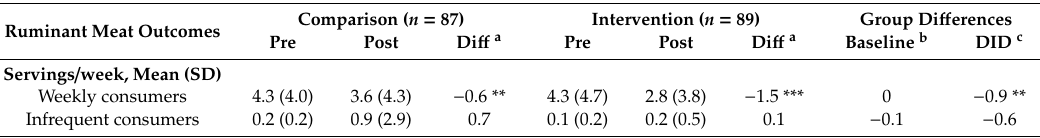
Table 4. Ruminant meat outcomes by group and di ff erences between groups, stratified by reported ruminant meat in take at baseline ( n =